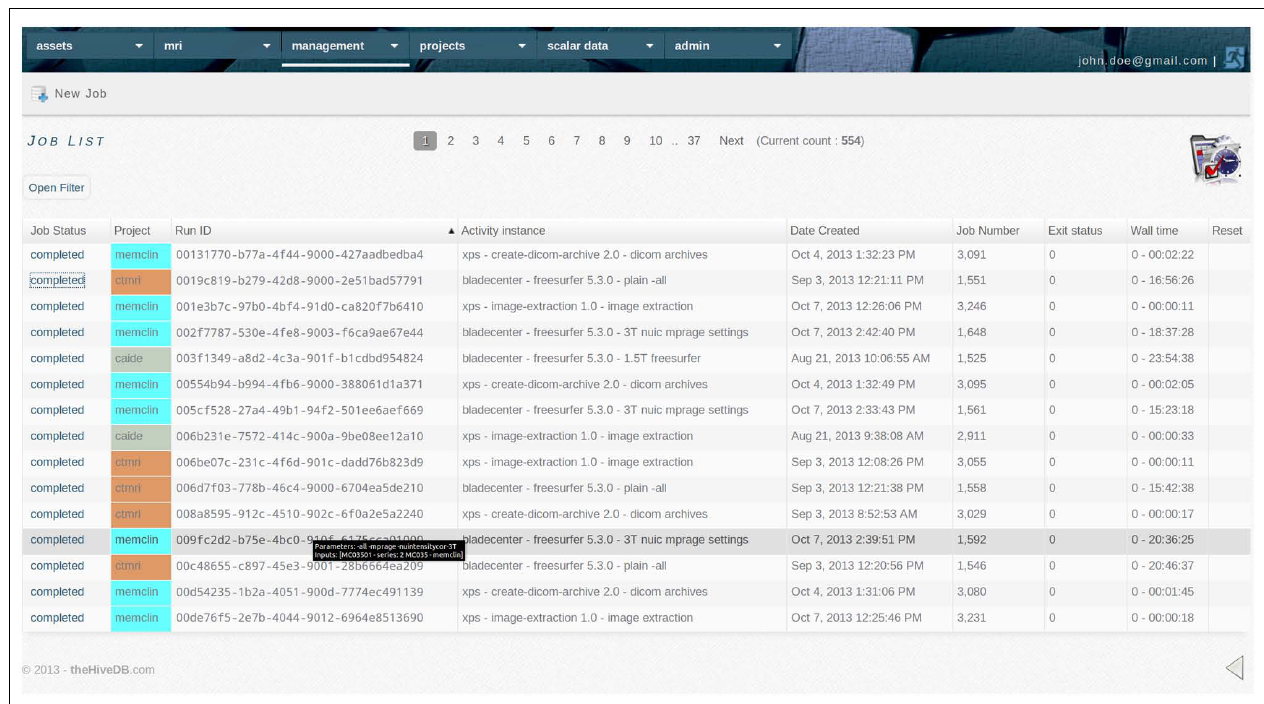
FIGURE 6 |The activity system keeps a track record of all activities performed by the system or requested by users. It communicates with remote resources for status updates and retrieves output collections automatically. Accounting information is compiled using the grid scheduler’s accounting output.